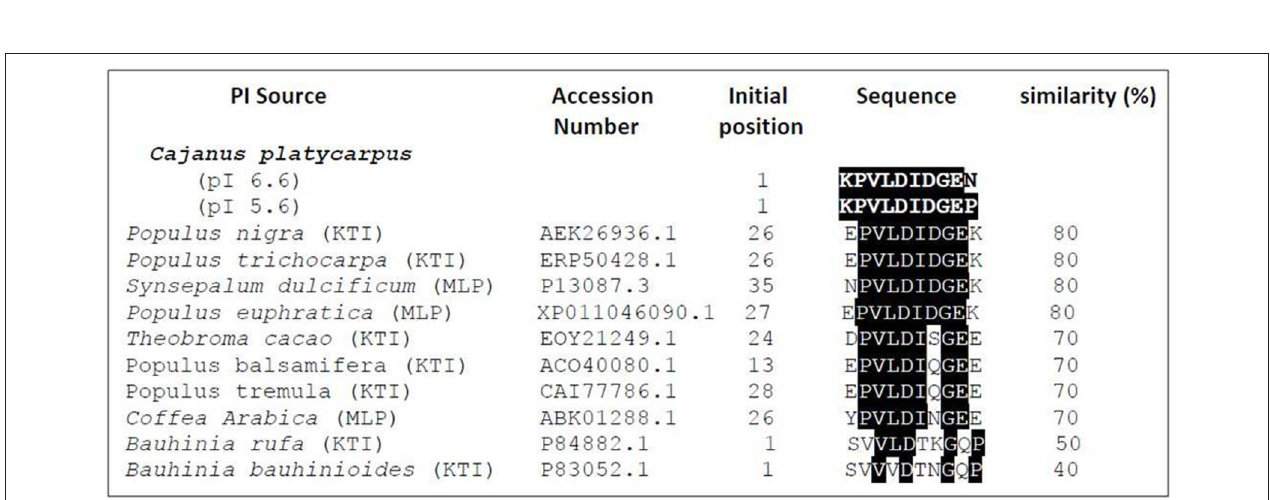
FIGURE 2 | Intact mass analysis of different isoinhibitors of CpPI 63 purified from mature seeds of C. platycarpus using MALDI-TOF mass spectrometer and 2-D electrophoresis. MALDI-TOF mass spectrum of CpPI 63 between m/z 0–60000 under non-reducing (A) and reducing conditions (B) i.e., after reduction and alkylation with DTT (50mM) and IDA (100mM), respectively; Separation of isoinhibitors of CpPI 63 (25 µ g) in 2-D electrophoresis under non-reducing (C) and reducing conditions (D) . Iso electric focusing (IEF) was performed using pH 4–7, 11cm strips as described in materials and methods. Second dimension was executed using tricine SDS-PAGE (18%). The data shown here are representative of three experiments performed independently with CpPI 63 purified from different experiments.